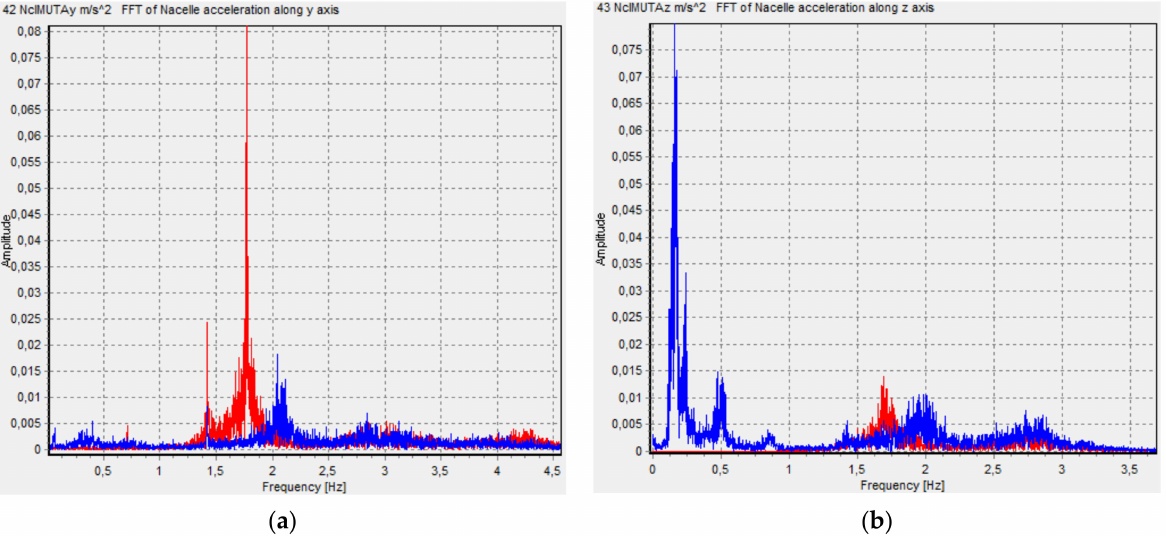
Figure 7. Comparison of FFT of nacelle acceleration along the y -axis ( a ) and z -axis ( b ) between the onshore (shown in red) and offshore (shown in blue) wind